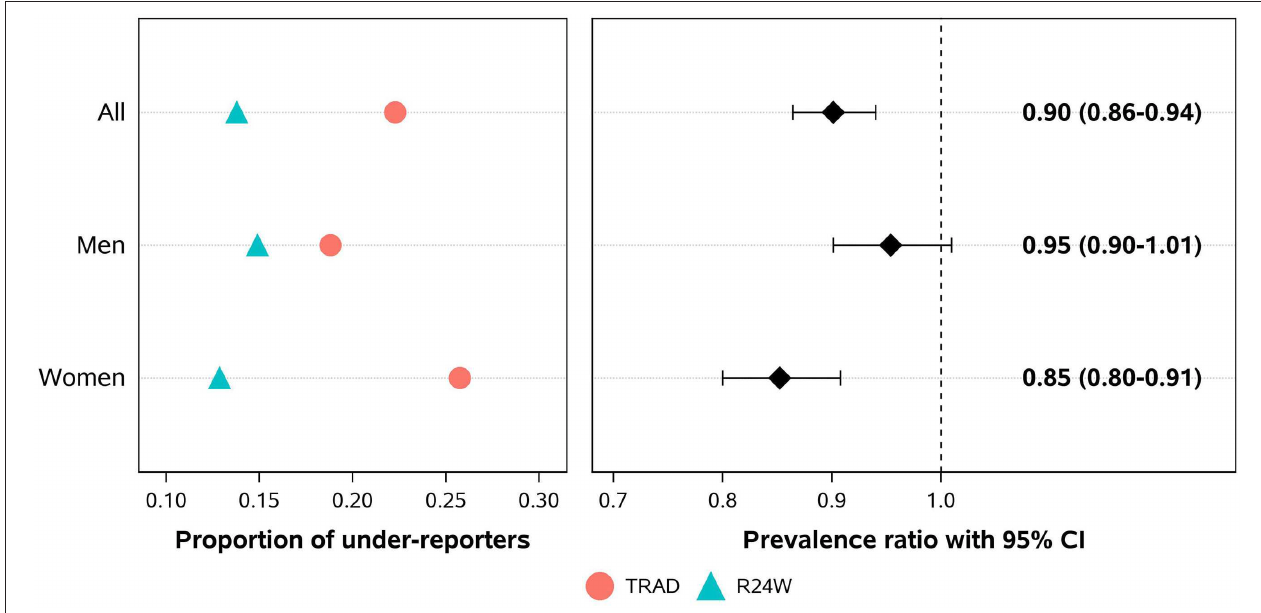
FIGURE 4 | Proportions and prevalence ratios of total energy intake underreporting using a self-administered web-based 24-h recall (R24W) compared with an interviewer-administered 24-h recall (TRAD) in comparable population-based samples. Data were adjusted for age, sex, administrative region, education level, body mass index, weekend, and season of survey through the sample balancing process using sex-specific sampling weights.